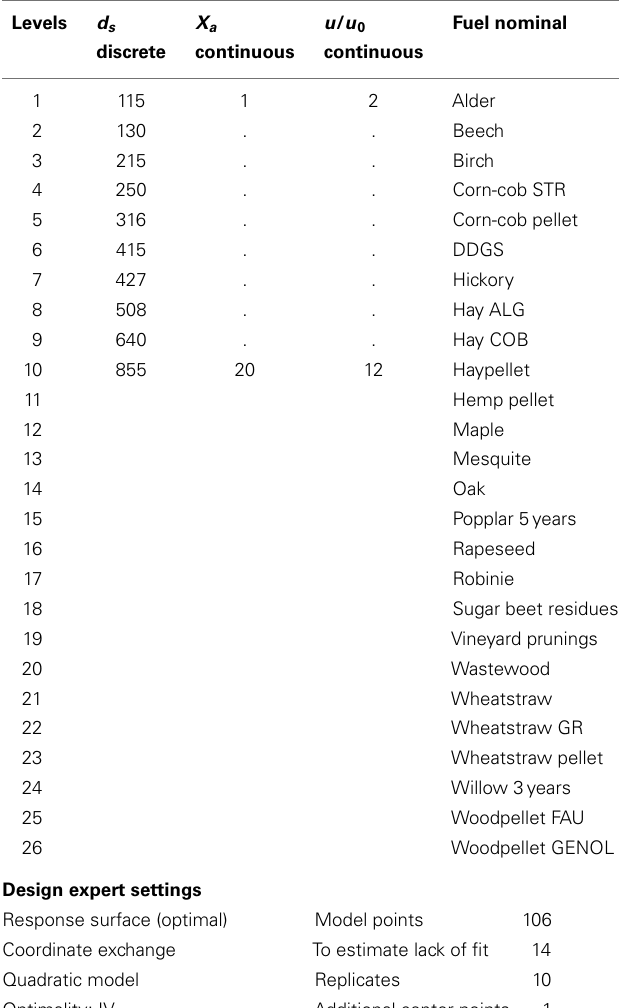
Table 5 | Criteria for experimental design and applied settings for DesignExpert v.8 .